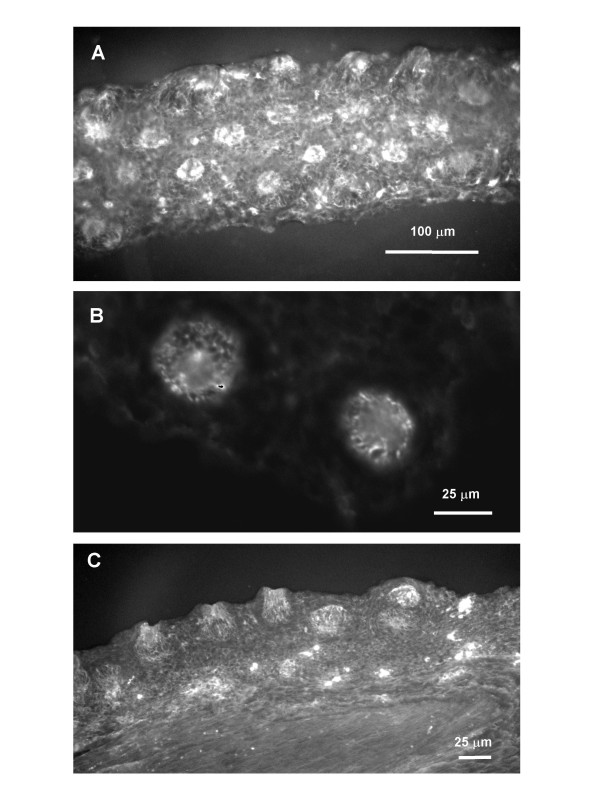
RCA-I lectin histochemistry on barbel of catfish, I. punctatus (albino). Barbels were fixed in 4% PFA, PBS, cryostat sectioned at 10 microns and histochemically probed with conjugated RCA-I at 1/200 dilution of the manufacturer's stock. (A). Surface labelling by RCA-I shows preferential recognition of binding sites primarily at the apical endings of taste buds. (B). Labelling by RCA-I of the apical region of two taste buds. (C). Labelling by RCA-I of horizontal section through the barbel showing reactive taste buds lining the epithelium.